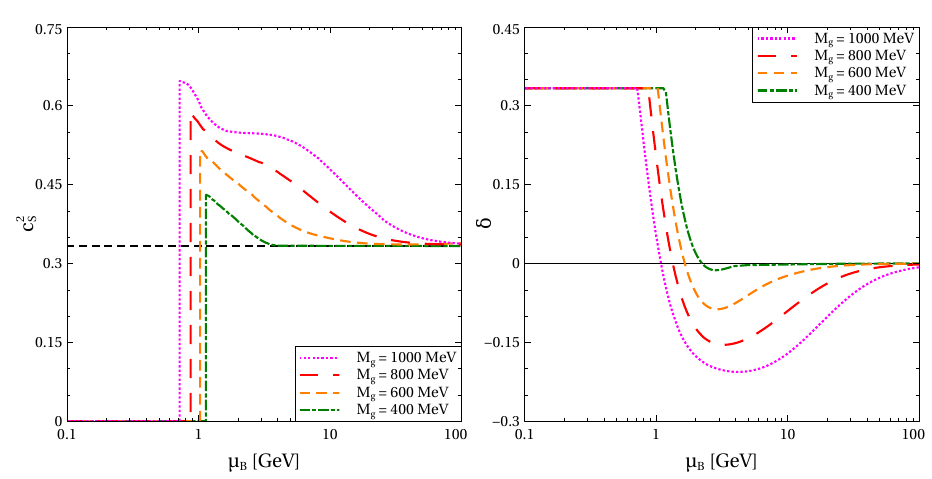
Figure 3. Squared speed of sound c 2 (left panel) and interaction measure δ (right panel) as functions of S baryonic chemical potential µ B . The black dashed line on the left panel represents c 2 tions are performed for cold symmetric quark matter at η V = 0 . 32 and η D = 0 .